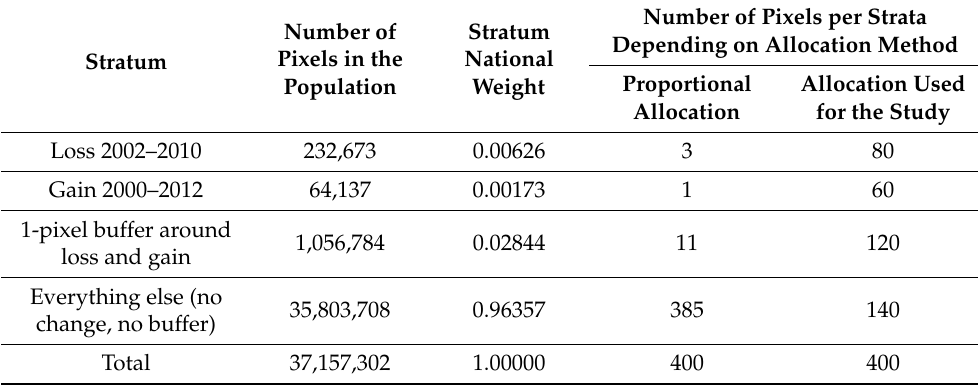
Table 1. Size and proportion of each stratum in the population and in the selected sample.